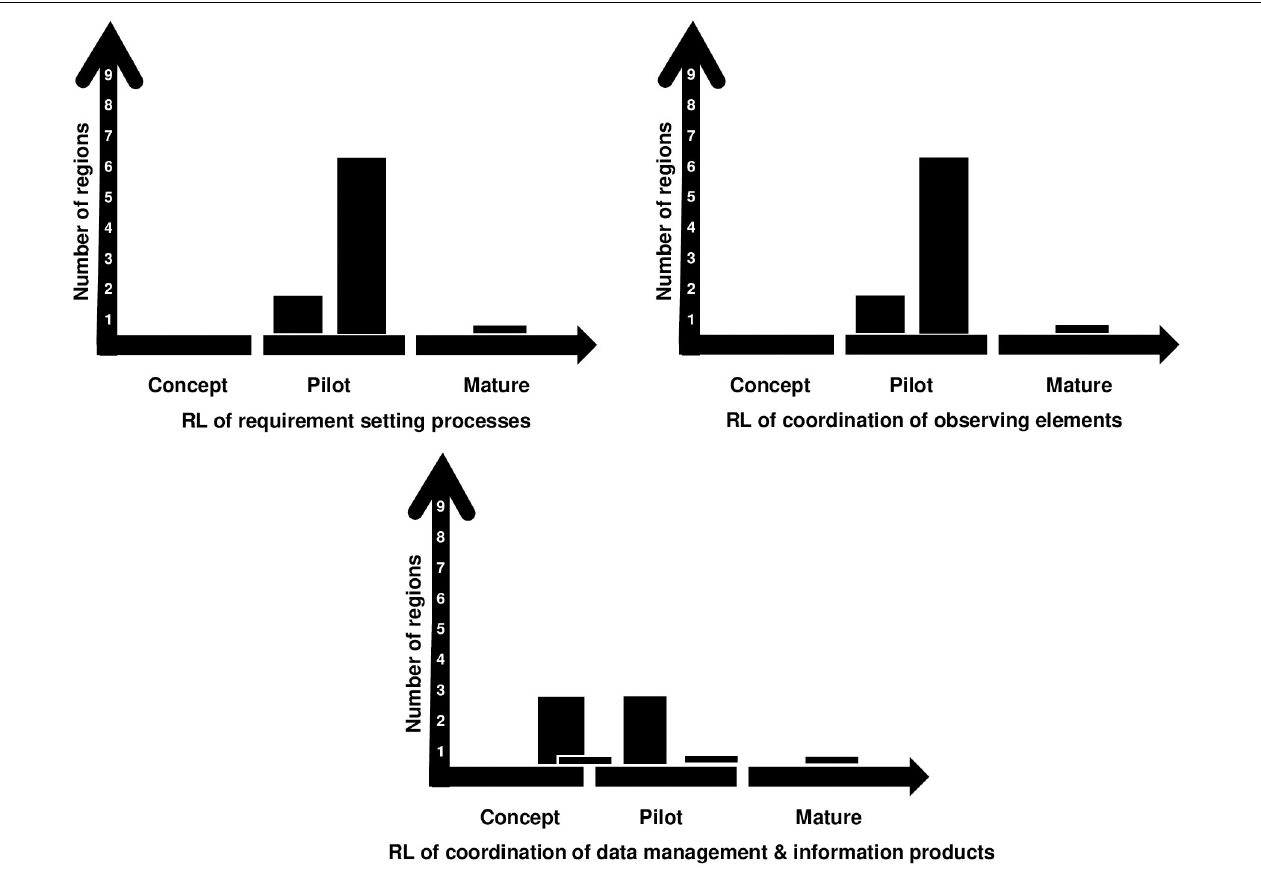
FIGURE 7 | Tentative assessment of readiness levels for Framework for Ocean Observing (FOO) pillars no. 1, 2, and 3 for all selected oxygen minimum zone (OMZ) regions.